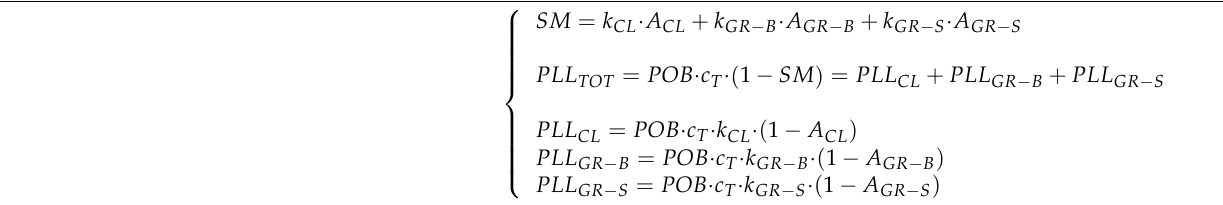
Table 4. Risk-based safety metric SM for cruise ships and RoPax, based on FLARE risk models. k CL k GR − B k GR − S c T (-) (-) (-) (1/Ship-Year) Cruise 0.05 0.38 0.57 1.07 × 10 − 2 RoPax 0.25 0.34 0.41 1.96 × 10 − 2